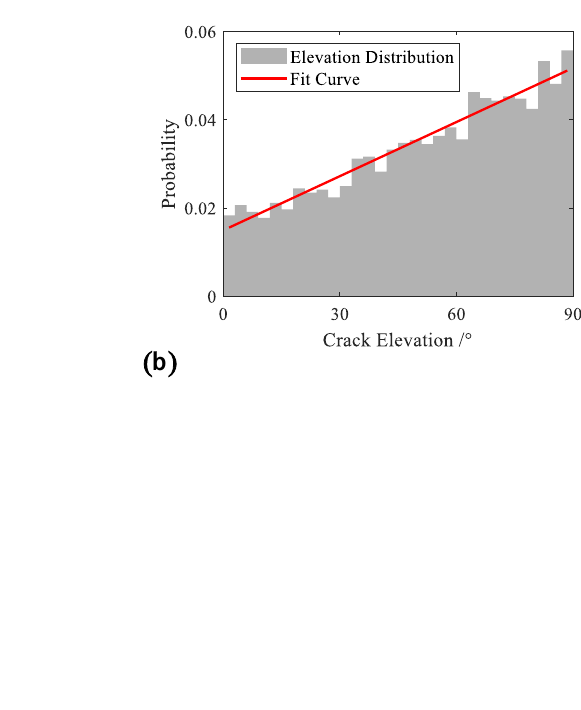
Figure 6. Stress field with different strain state.